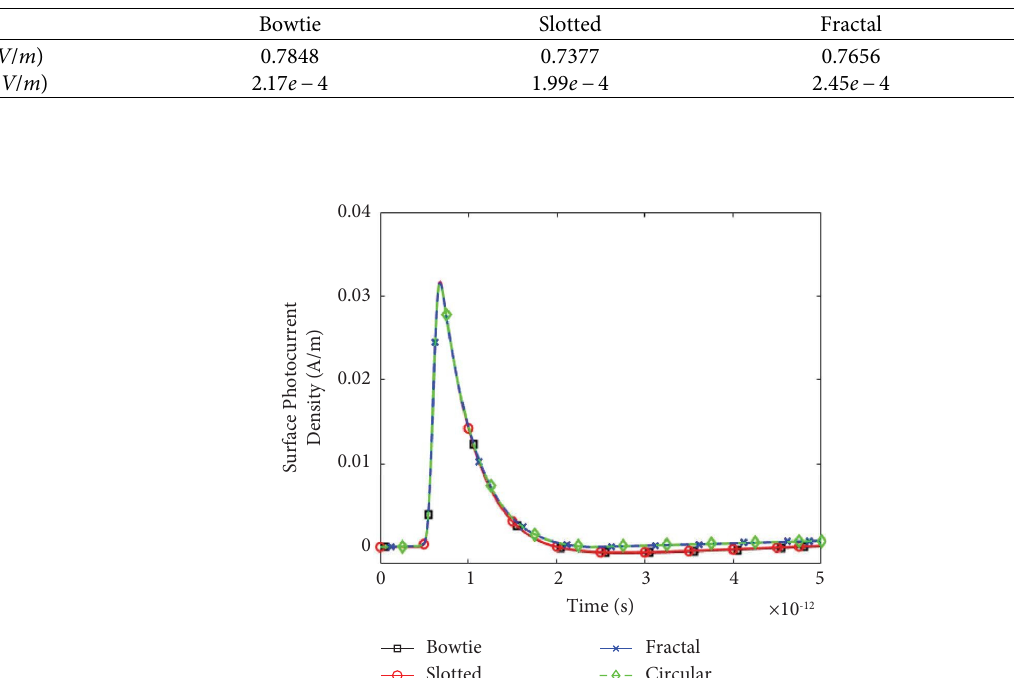
Figure 11: 3D modeled photoconductive surface current density of the four PCAs considered here. Te electrodes were positioned on a multilayer of 250nm LT-GaAs and half-space SI-GaAs, achieved in COMSOL by using a 400nm thick layer and the scattering boundary